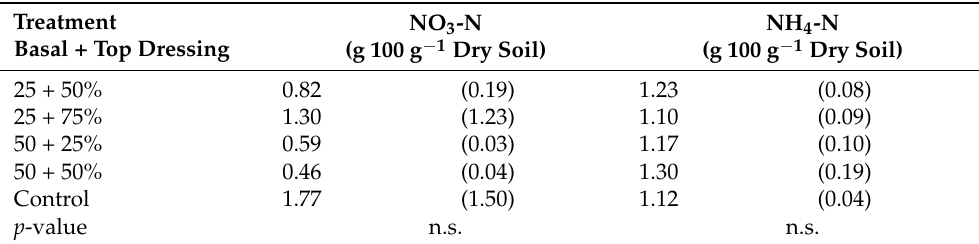
Table 4. Effects of variable fertilization on soil nitrate and ammonium concentrations obtained using potassium chloride extraction after the harvest (Trial 3). Values represent the median obtained from three replicates (standard deviation). p -values from the Kruskal–Wallis test are shown. n.s. indicates no significance at p <